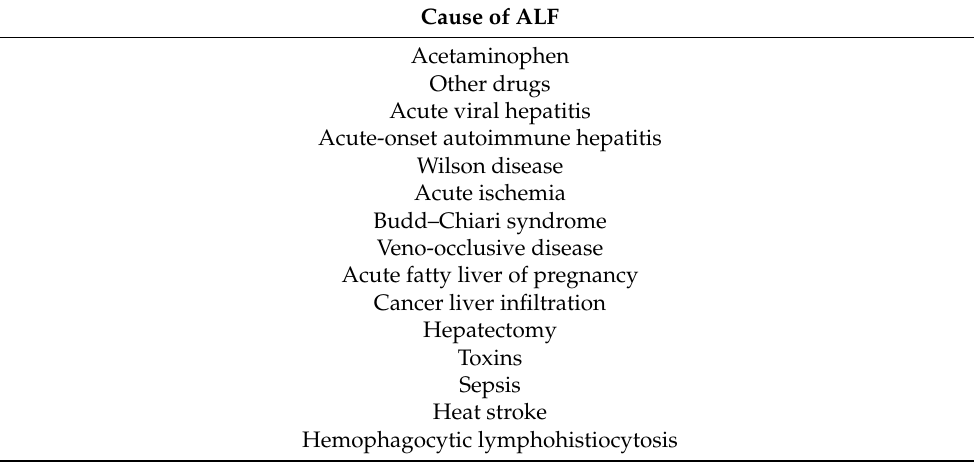
Table 1. Main causes of